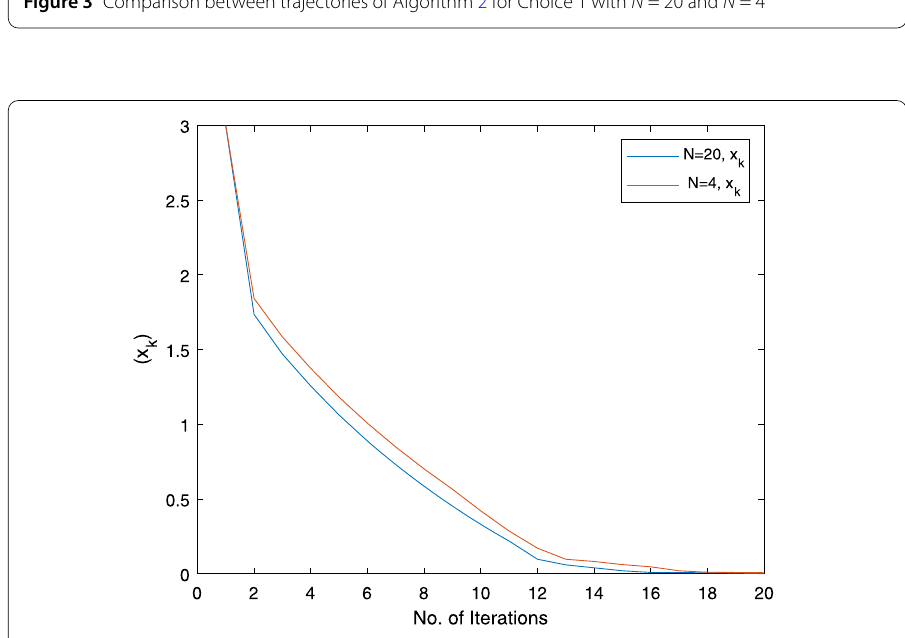
Figure 4 Comparison between trajectories of Algorithm 2 for Choice 2 with N = 20 and N =